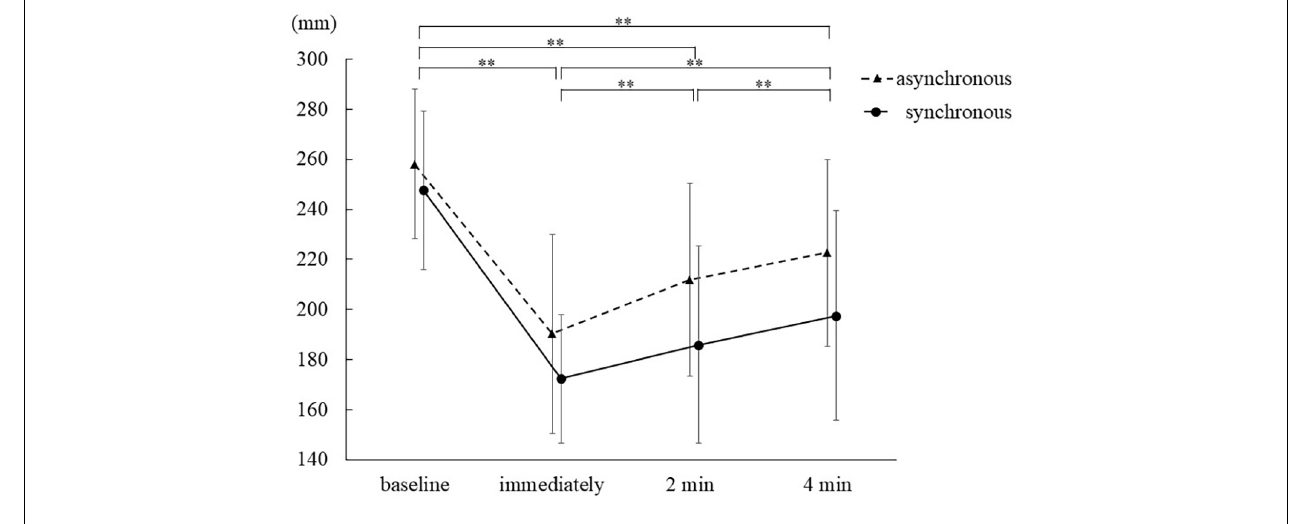
FIGURE 3 | Proprioceptive drift results. ∗∗ p < 0.01.